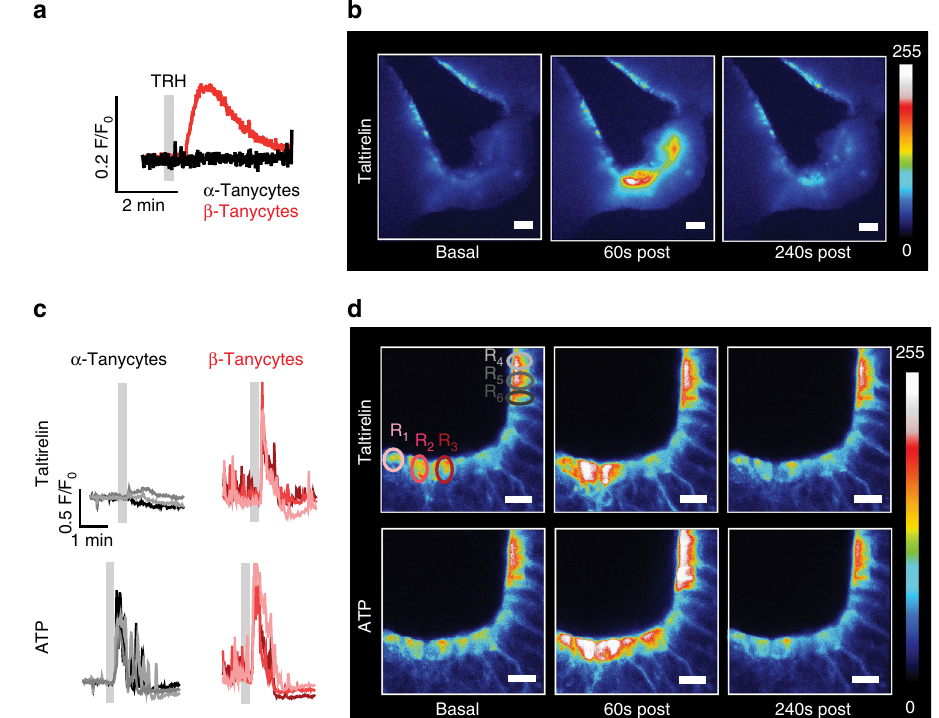
Fig. 1 TRH receptor agonists increase [Ca 2+ ] i selectively in tanycytes of the median eminence. a and b TRH and the TRH receptor agonist taltirelin increased [Ca 2+ ] i in tanycytes of the ME 2 weeks after rAAV-mediated transduction of the calcium sensor GCamP6s. a After treating hypothalamic slices with TRH (33 µ M, gray bar ), only β -tanycytes ( red line ) responded with an increase in [Ca 2+ ] i but not α -tanycytes ( black line ). Representative traces are shown. b Heat maps of fl uorescence intensity visualized the location of responsive cells after taltirelin stimulation (33 µ M). Scale bar , 50 µ m. c Single-cell calcium responses after stimulation with taltirelin (150 µ M, gray bar , top ) and ATP (150 µ M, gray bar , bottom ) in tanycytes of the ME ( red , R 1 – 3 ) and the ventricular wall ( gray , R 4 – 6 ). The regions of interest that were imaged by confocal microscopy are indicated in d (R 1 – 6 ). d Representative heat maps after stimulation with taltirelin (150 µ M, top ) and ATP (150 µ M, bottom ) in acute brain slices of GCamP6s-transduced mice. Regions of interest are indicated in the ME (R 1 – 3 , red ) and the ependymal layer of the 3rd ventricle (R 4 – 6; gray ). Scale bar , 25 µ